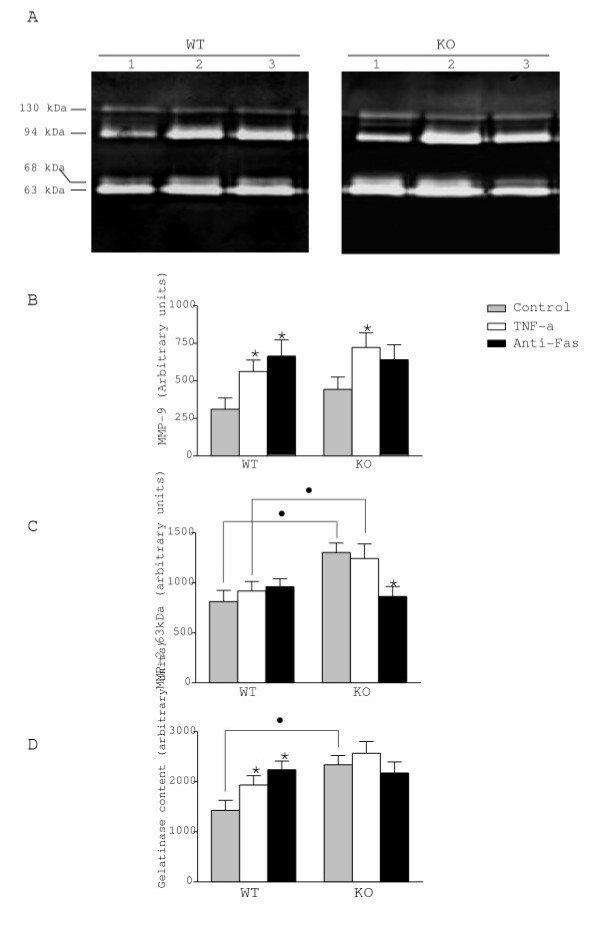
Expression of MMP-9 and MMP-2 in astrocytes. A. Gelatine zymograms from culture supernatants of WT and KO astrocytes in control condition (lane 1) or after treatment with TNF-α (lane 2) and anti-Fas antibody (lane 3). Quantitative expression of the 94 kDa (MMP-9) (B) and the 63 kDa form of MMP-2 (C). Constitutive levels of MMP-2 in KO were higher than in WT astrocytes. MMP-9 was up-regulated by TNF-α in both strains of astrocytes. Fas activation significantly induced MMP-9 expression in WT astrocytes but not in KO astrocytes. D. Total gelatinase expression detected in gel zymography. The total gelatinase expression was higher in KO astrocytes as compared to WT astrocytes. TNF-α and anti-Fas treatments increased total gelatinase expression only in WT astrocytes. Values represent the mean +/- s.e.m. of at least three independent experiments. Statistical differences were determined by Student's t-test when comparing treatments to control cells within a given genotype (* p < 0.05) or KO vs WT cells (● p < 0.05).